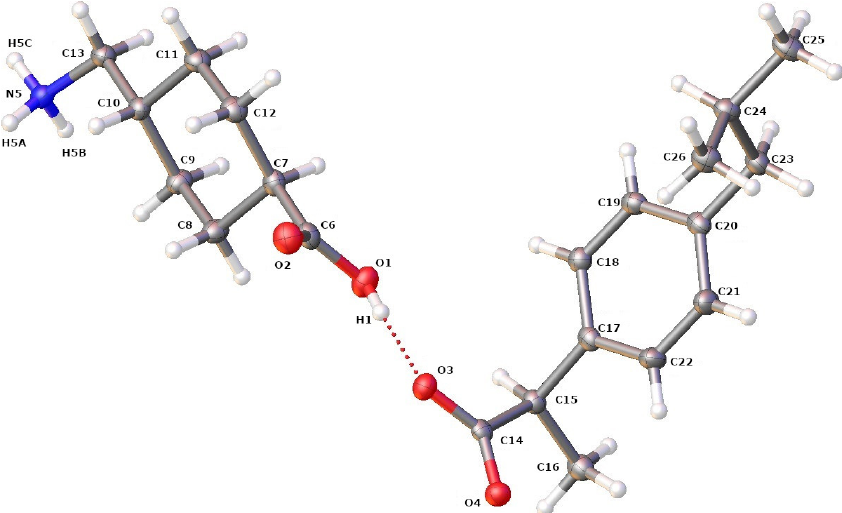
Figure 7. ORTEP diagram of IBP and TXA in salt showing the atom numbering scheme. The hydrogen atoms are shown as small white spheres with arbitrary radii.